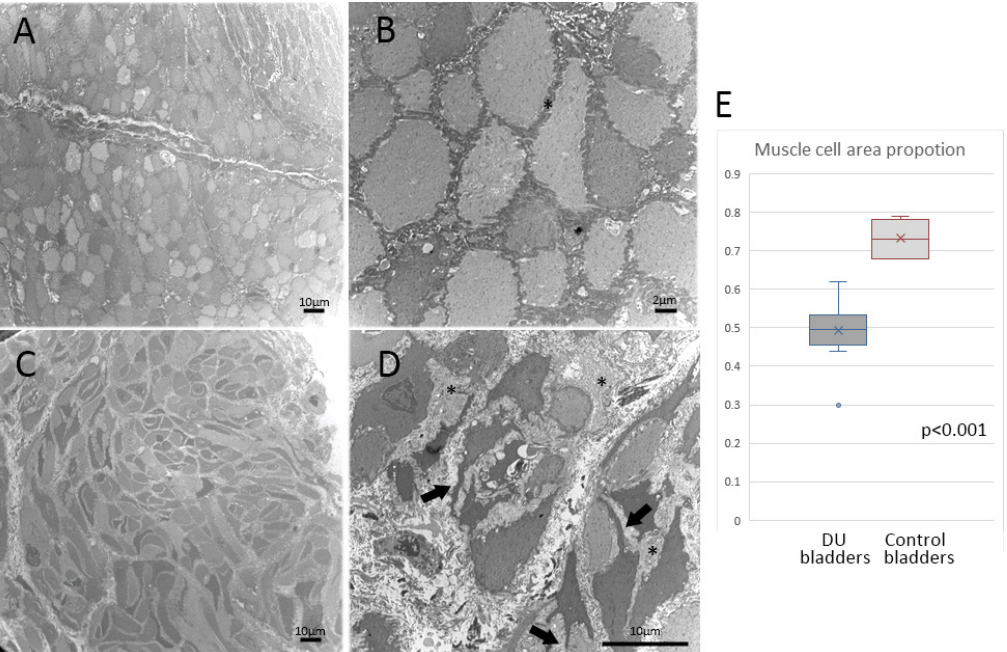
Figure 3. Representative images of EM detrusor muscles. ( A , B ) Bladder detrusor layer images taken from control subjects showing normal smooth muscle morphology with tight intercellular spaces (indicated by asterisks, *). ( C , D ) Bladder detrusor layer images taken from patients with DU showing loss of regular spindle shape in longitudinal sections or round shape in cross-sections. Ruffled cell contour with several cytoplasmic processes (arrows) spanning the enlarged intercellular space (*). ( E ) Median proportion of muscle cell area in DU ( n = 12) and control bladders ( n = 4). An intact epithelial layer and the presence of lamina propria nerve terminals were significantly correlated with the urodynamic parameters. Patients with DU with intact epithelial cell layers had significantly larger voided volumes and Qmax than those with mild or severe epithelial denudation (Table 3). The patients with DU with nerve terminals in the lamina propria had smaller FSF, FS, and PVR than the patients without nerve ter- minals in the lamina propria. The other bladder EM findings were not correlated with the urodynamic parameters (Supplemental Table). The treatment outcomes and etiologies of DU were not associated with the bladder findings on EM. Age did not differ significantly between the patients with DU and the various EM findings. Table 3. Clinical parameters in patients with DU with bladder EM defects of varying severities.